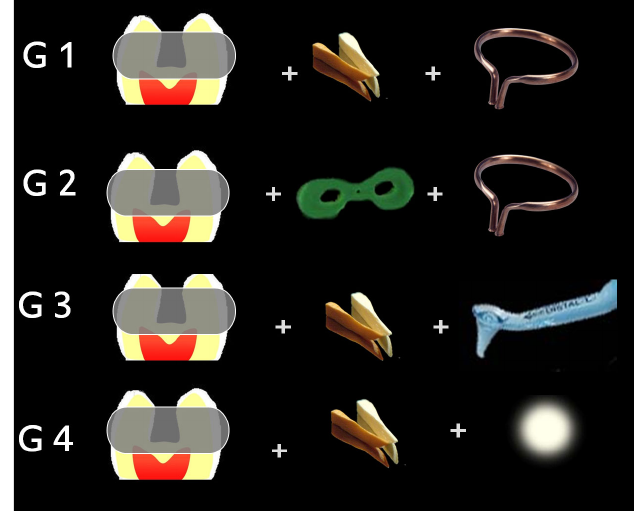
Fig. 1. Illustration of the of experimental